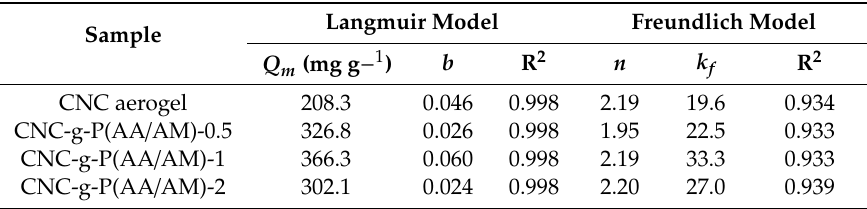
Table 3. Adsorption isotherm parameters for the Langmuir and Freundlich models.